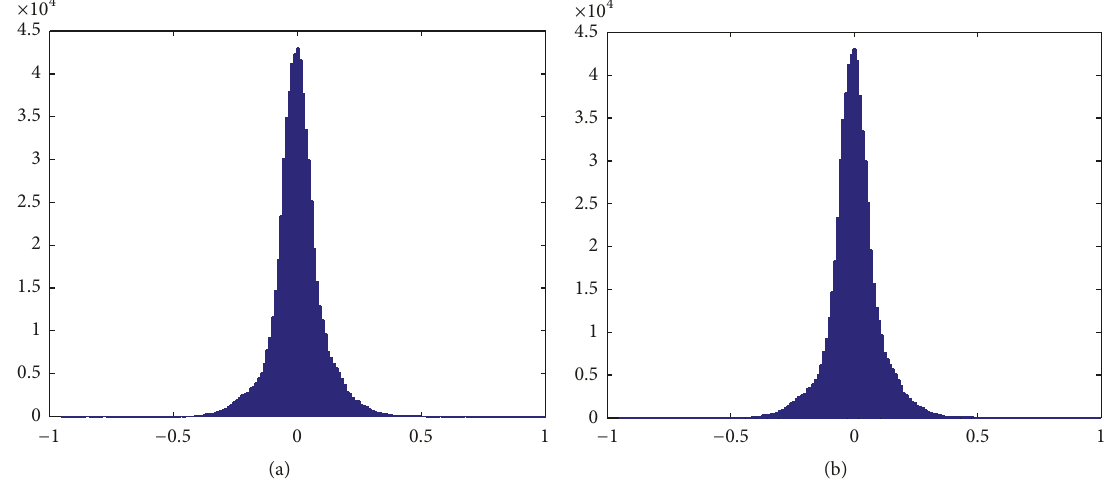
Figure 11: Histograms of original and embedded